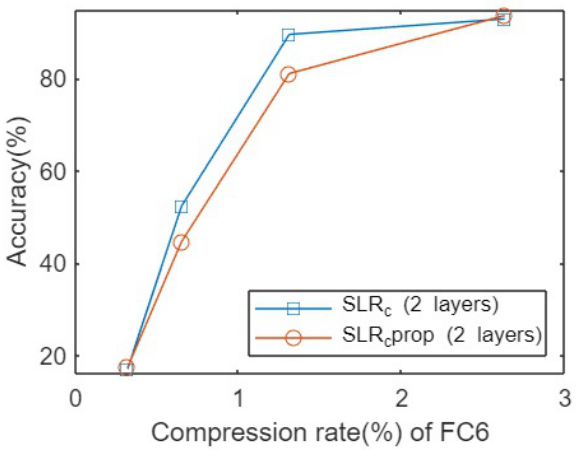
Figure 2. Accuracies for pruning VGG16 network on Cifar10 dataset for different compression rates.